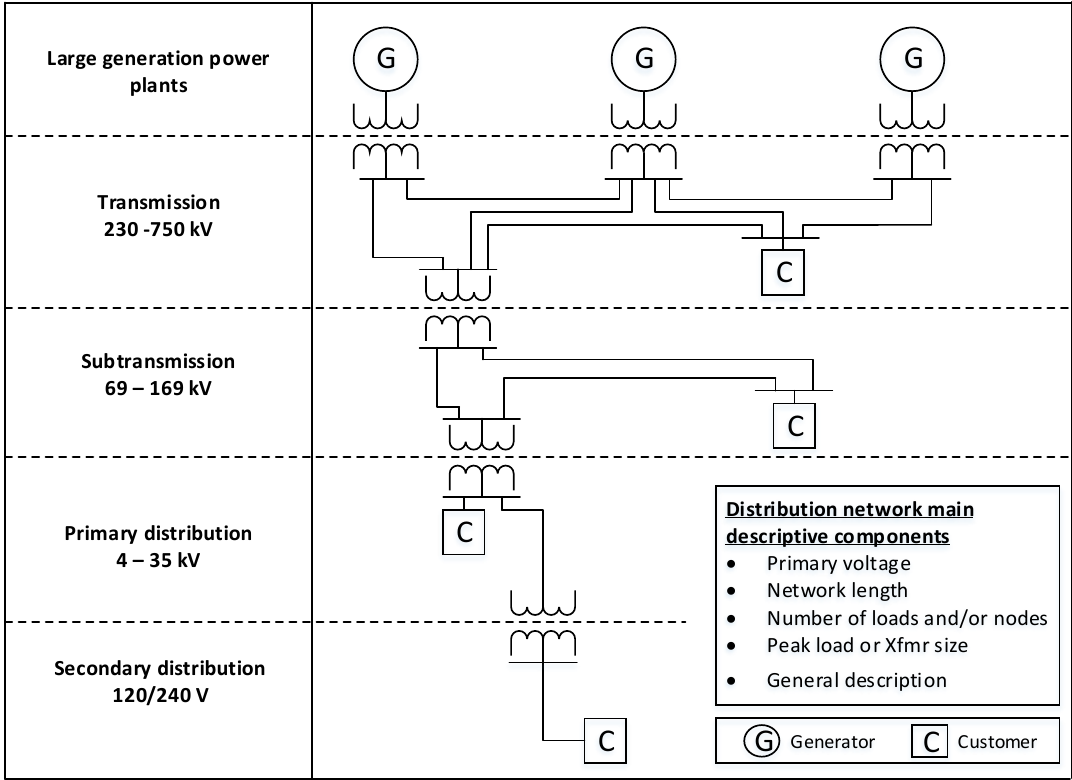
Figure 1. Power system infrastructure grouped by voltage levels.